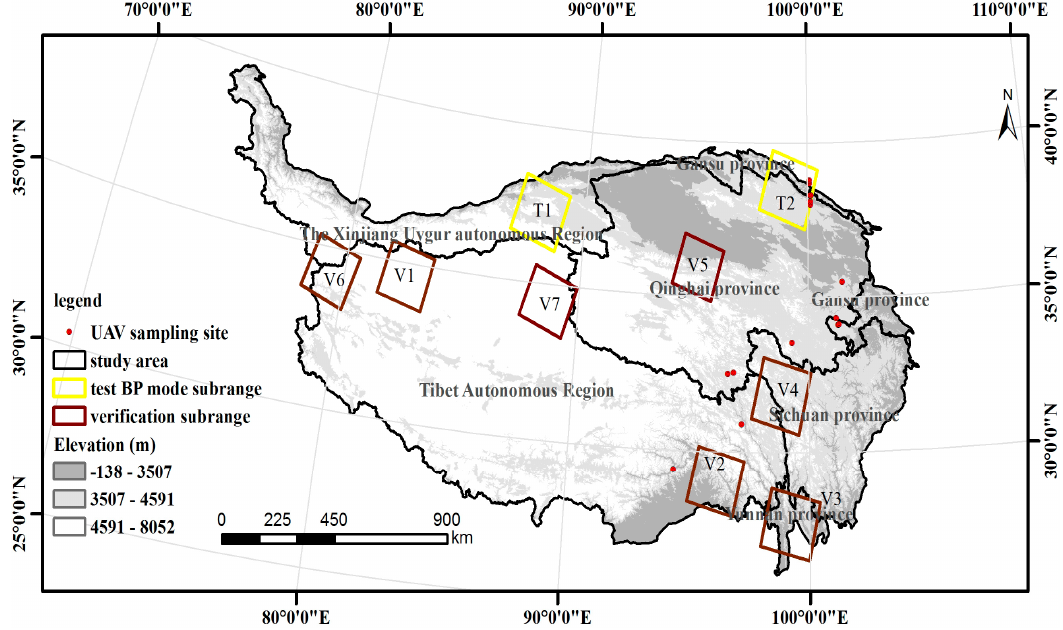
Figure 1. Shuttle Radar Topography Mission (SRTM)-Digital Elevation Model (DEM) based elevations and locations of the unmanned aerial vehicle (UAV) sampling sites over the Tibetan Plateau region. V1–V7 denote the seven Landsat images used for validating the three models and T1–T2 denote the test sites for the BP artificial neural network models.